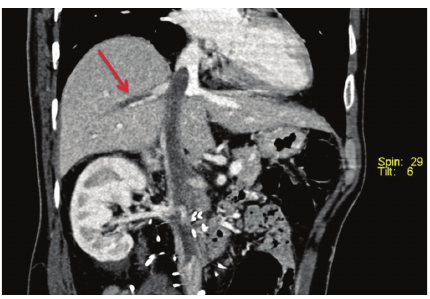
Figure 2: Reformatted coronal CT image demonstrating tumour thrombus in the inferior vena cava, extending into the right hepatic